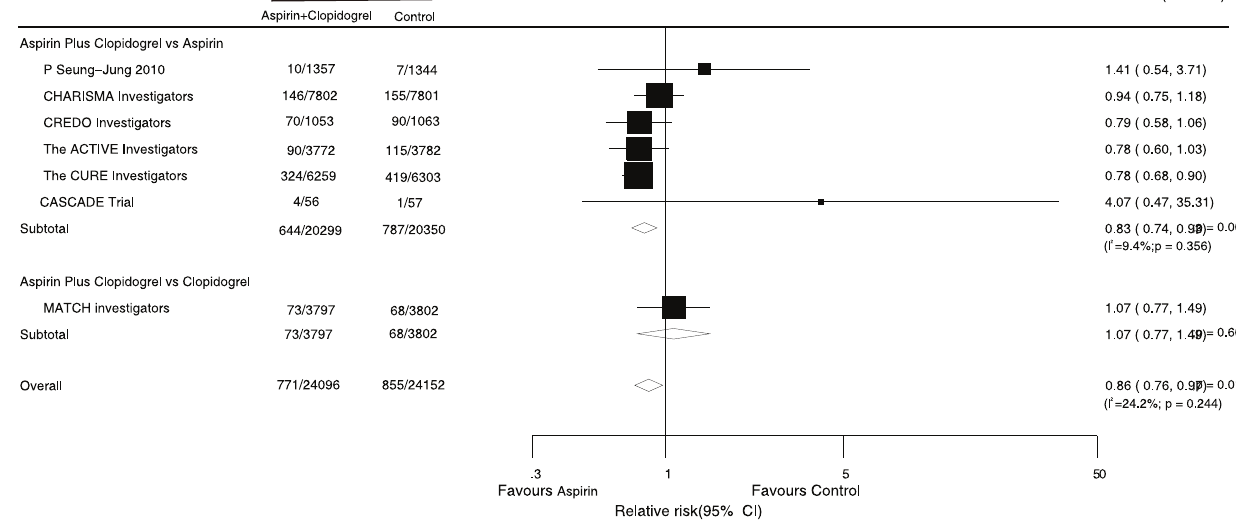
Figure 3. Effects of aspirin with clopidogrel therapy on risk of myocardial infarction.